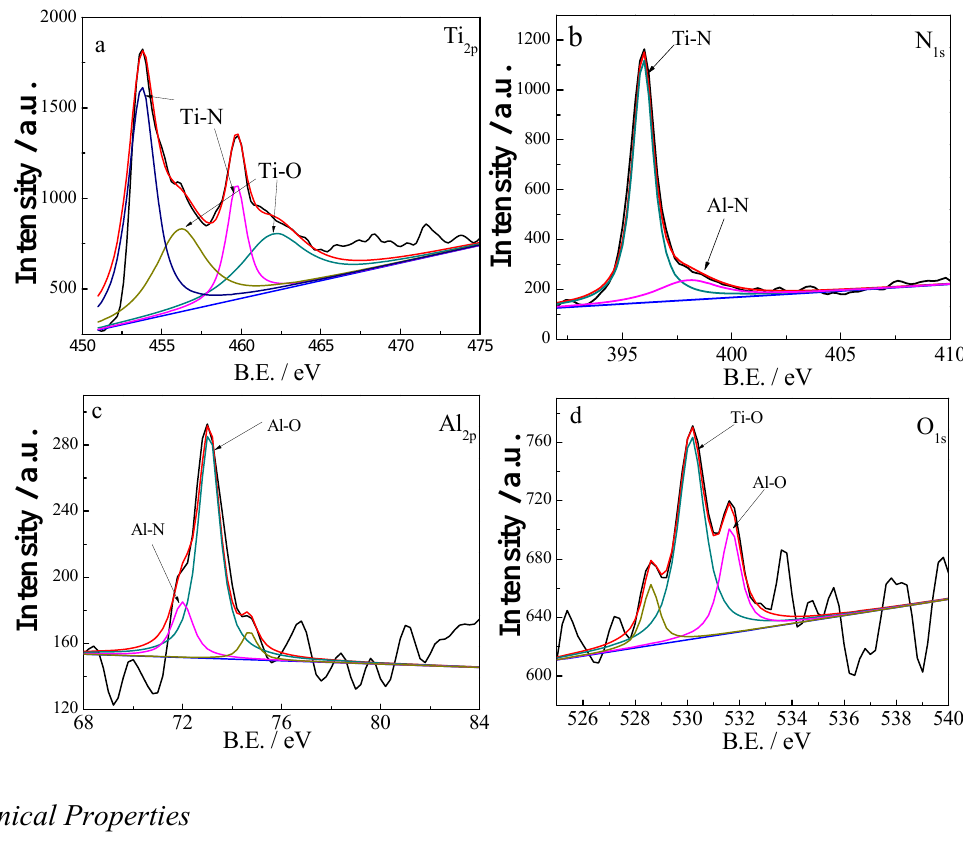
Figure 3. High resolution X-ray Photoelectron Spectroscopy (XPS) spectra of Ti , O electrons for the TiAlN/Al Al 2p 1s